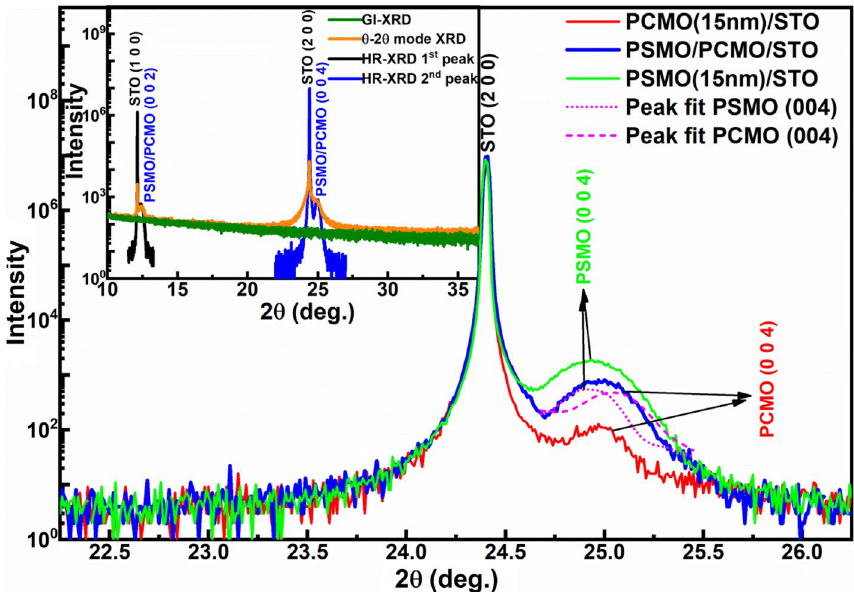
Figure 1. HR-XRD of PSMO/PCMO/STO heterostructure near (2 0 0) reflection of STO. Inset shows the XRD pattern obtained in GI, θ−2θ, and HR modes for the